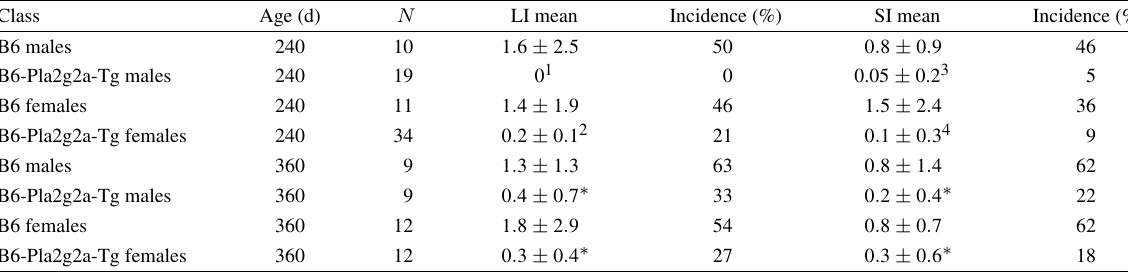
Tumor multiplicity and